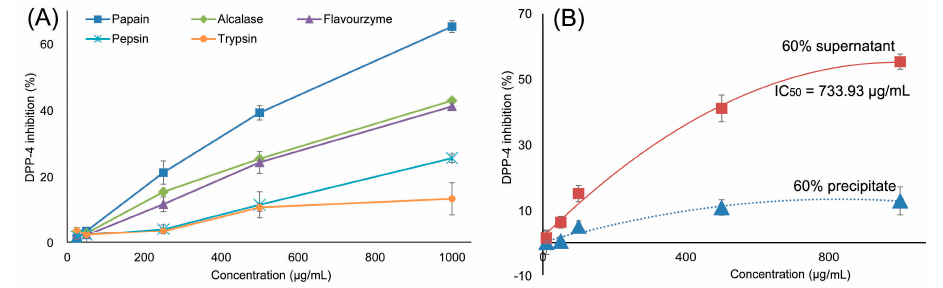
Figure 1. ( A ) DPP-IV inhibitory activities of RPHs produced by different proteases. The IC 50 of RPHs produced by Papain is 672.12 μ g/mL; ( B ) DPP-IV inhibitory activities of 60% precipitate and supernatant, and the IC 50 of 60% supernatant is 733.93 μ g/mL.